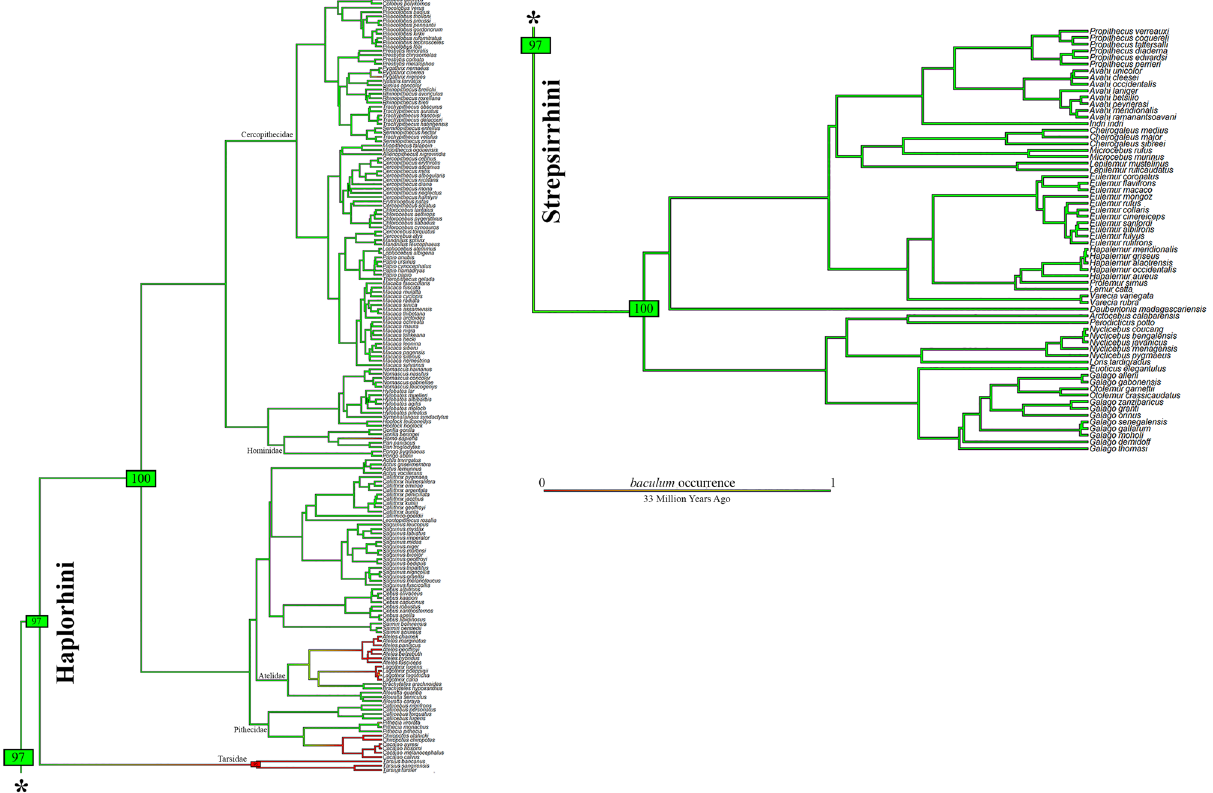
Figure 2. Ancestral character state reconstruction of baculum excluding outgroups. Results from 1000 stochastic character maps (where the character analyzed is the baculum occurrence) displayed in aggregate (outgroups were excluded from the analysis). The colour of edges in the tree gives the posterior probability (computed as the relative frequency across stochastic maps) of each baculum state through the history of the clade. Green indicates a high posterior probability of baculum presence and numbers in green (or red) boxes indicate the proportion of iterations that mapped baculum occurrence to those particular branches. The length of the legend also gives a scale for the tree branch length (in this case in Millions of Years Ago). Phylogeny by Springer 71 , dropped. Figure generated in R (v. 4.0.3, https:// www.R- proje ct. org/) 114 mapping. The root of the coloured tree (Fig. 2) appeared as total-green, attesting to a high probability of bacu- lum presence in the primate ancestor. Losses involved 5 families: Tarsidae (the few species available); Pithecidae ( Pithecia irrorata Gray, 1842, and the Chiropotes + Cacajao clade); Atelidae ( Ateles clade and Lagothrix clade—if we exclude the doubtful case of L. lagothricha [Humboldt, 1812]); Hominidae ( Homo sapiens Linnaeus, 1758); Cercopithecidae ( Pygathrix nigripes [A. Milne-Edwards, 1871]).